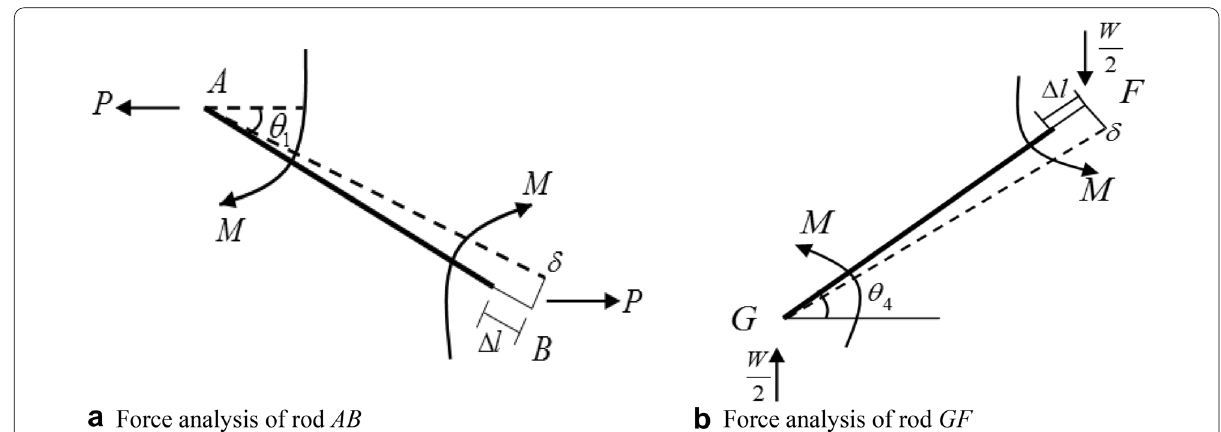
Figure 8 Force analysis of rods AB and GF in the σ 1 and σ 2 directions,